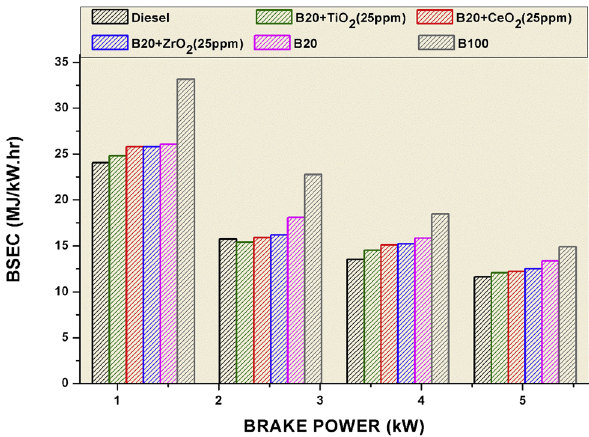
Figure 3: The BSEC for fuel blends with nanoparticles [ 76 ]